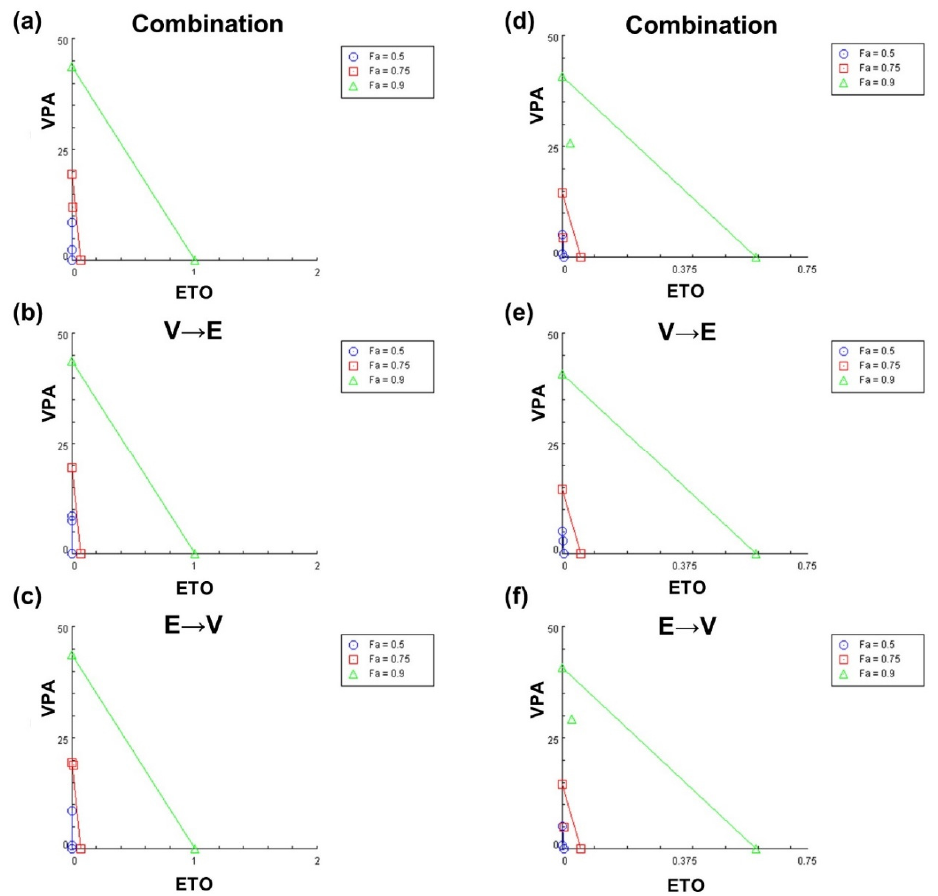
Figure 5. Isobologram analysis of the synergistic and antagonistic effects of different VPA and ETO treatment schemes. The isobolograms analysis revealed the degrees of effectiveness of the specified treatment scheme on inhibiting B16-F10 and SK-MEL-2-Luc cells. Specifically, ( a ) simultaneous combined treatment of VPA and ETO, ( b ) sequential combination with VPA pretreatment, and ( c ) sequential combination with ETO pretreatment in B16-F10 cells; ( d ) simultaneous combined treatment of VPA and ETO, ( e ) sequential combination with VPA pretreatment, and ( f ) sequential combination with ETO pretreatment in SK-MEL-2-Luc cells. The individual doses of VPA and ETO that attained 50% (Fa = 0.5), 75% (Fa = 0.75), and 90% (Fa = 0.9) inhibitory effects (i.e., effective dose, ED) are designated as blue lines, red lines, and green lines, respectively. The CI values at ED 50 , ED 75 , and ED 90 are indicated as blue circle, red square, and green triangle symbols, respectively. Symbols above the line, on the line, or below the line represent antagonistic, additive, or synergistic effects, respectively.